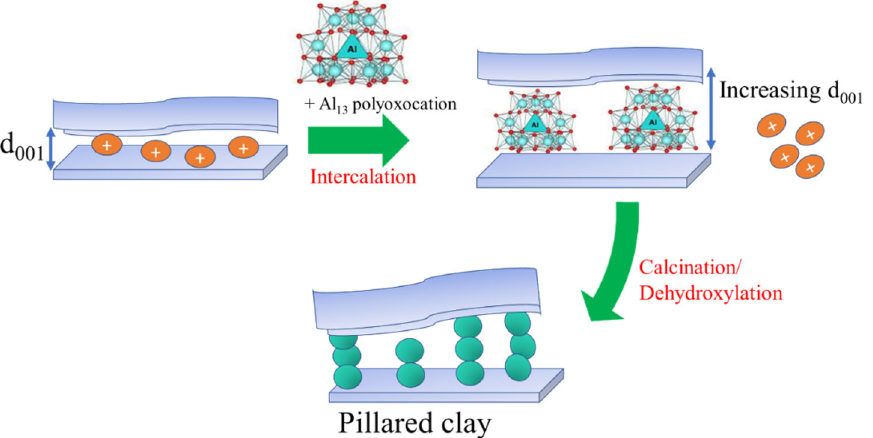
Figure 6. Schematic representation of clay pillarization.